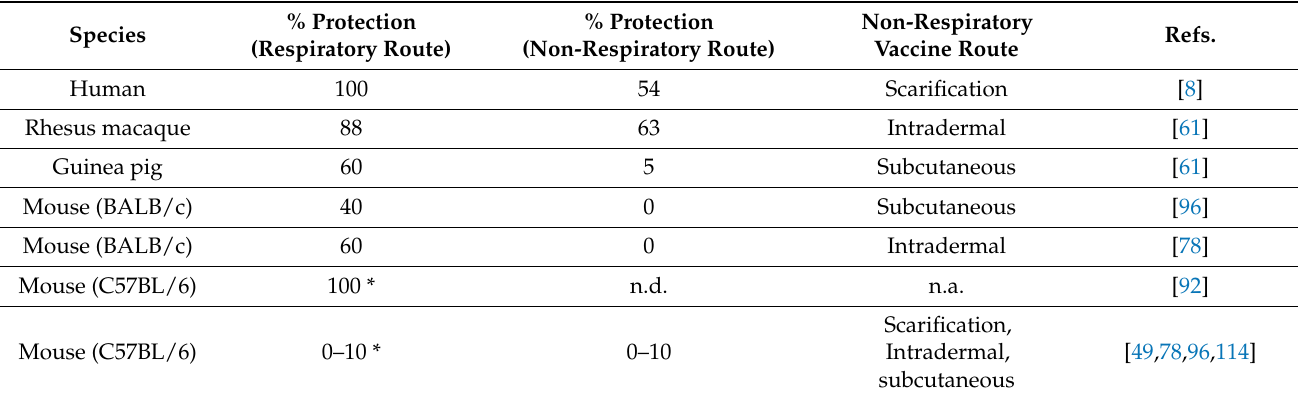
Table 1. A summary of the data from studies comparing vaccination routes and protection elicited by LVS. All data shown are for respiratory challenges with virulent subsp. F. tularensis strains. “Protection” is defined as no need for antibiotic treatment for humans and survival for all